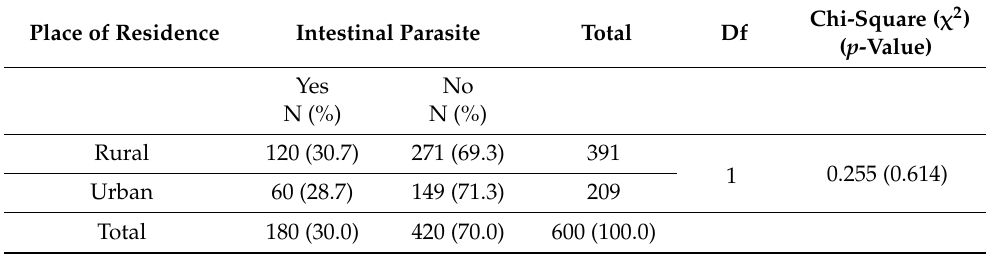
Table 3. Prevalence of intestinal parasites by place of residence.